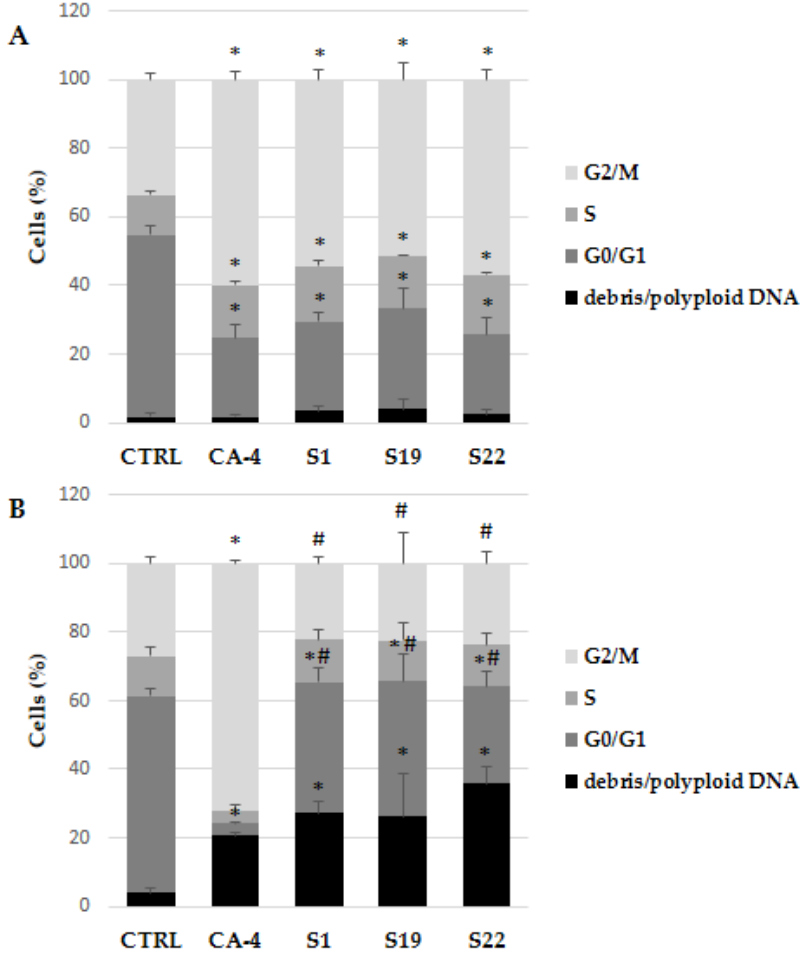
Figure 3. Flow cytometry analysis of cell cycle in A375 cells using PI staining after exposure to indicated compounds (at 10 µM) for 6 h ( A ) and 24 h ( B ). Data are expressed as the mean and SD from three independent experiments; * p < 0.05 vs. ctrl; # p < 0.05 vs. CA-4.